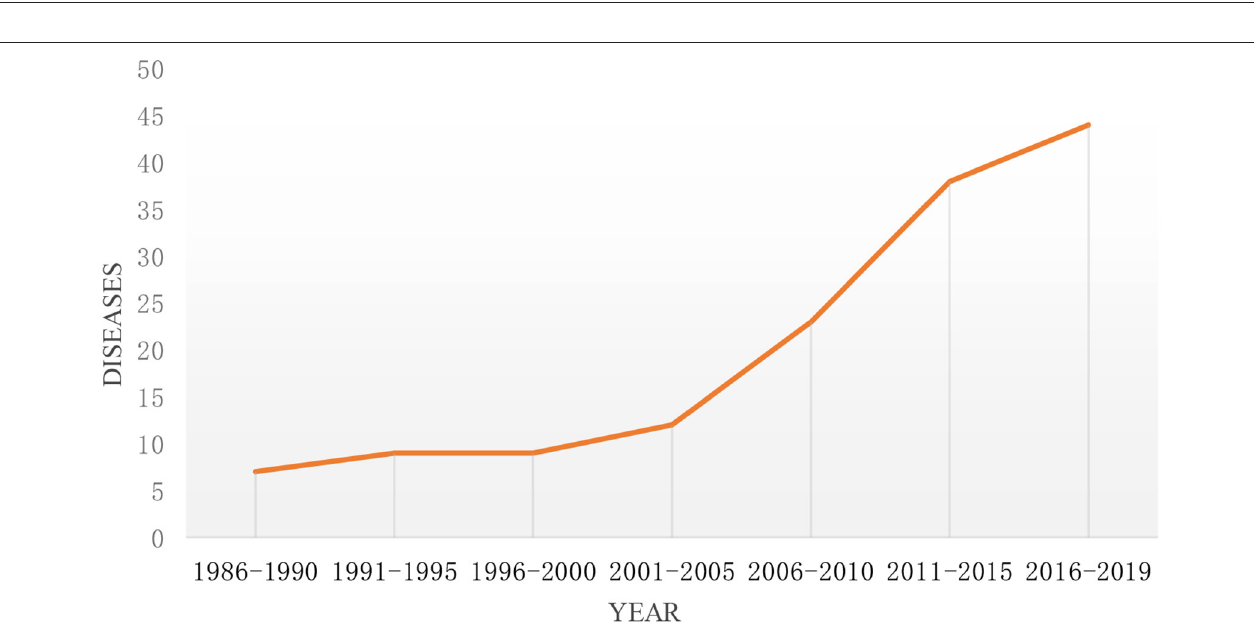
FIGURE 2 | The trend of the types of rare diseases funded by NSFC and its change every year from 1986 to 2019.